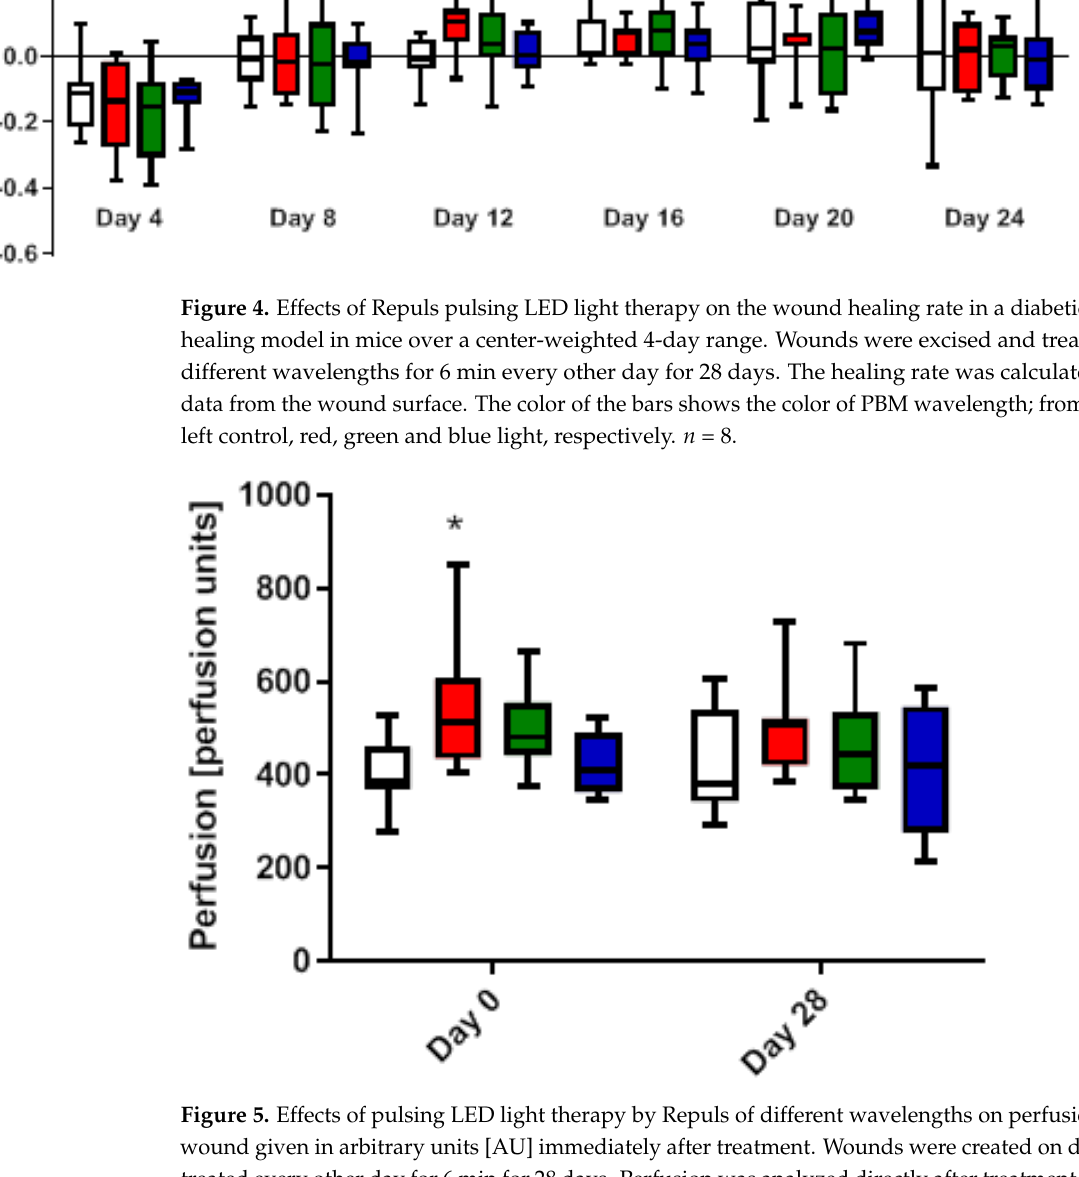
Figure 4. Effects of Repuls pulsing LED light therapy on the wound healing rate in a diabetic wound healing model in mice over a center-weighted 4-day range. Wounds were excised and treated with different wavelengths for 6 min every other day for 28 days. The healing rate was calculated using data from the wound surface. The color of the bars shows the color of PBM wavelength; from right to left control, red, green and blue light, respectively. n = 8.